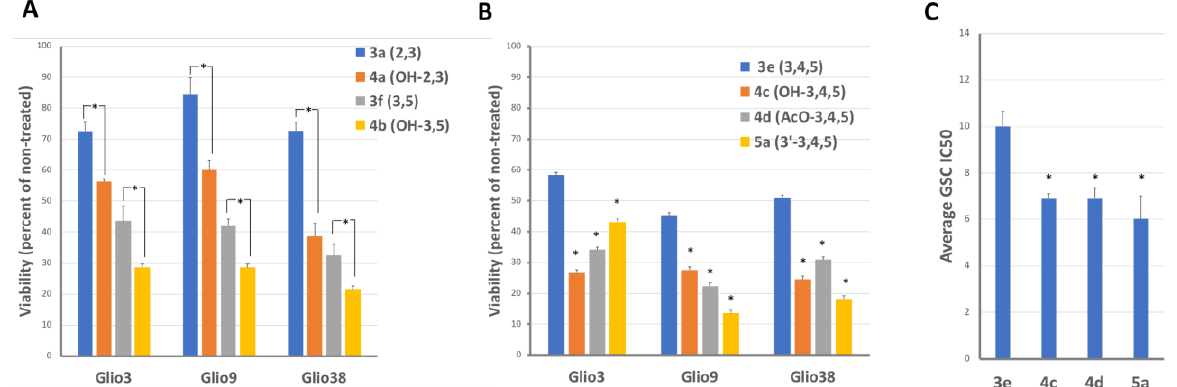
Figure 4. Hydroxy and Acetoxy derivatives or changing the position of the amino group are signif- icantly more effective than the 4′ amino chalcone. ( A ) GSCs were treated with 10 µM of amino and hydroxy dimethoxy chalcones ( 3a , 4a , 3f , 4b ) and viability determined 72 h later. ( B ) GSCs were treated with different 3,4,5 trimethoxy derivatives ( 3e , 4c , 4d , 5a ) and viability determined 72 h later. Data is presented as percent viability relative to non-treated controls. ( C ) IC 50 for trimethoxy derivatives ( 3e , 4c , 4d , 5a ). * p < 0.05, IC 50 of 3e verse 4c , 4d or 5a